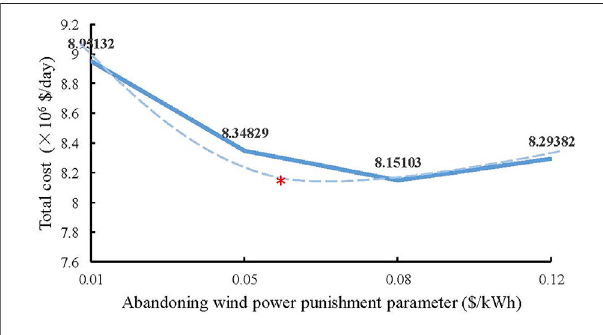
FIGURE 10 | Curve line chart of the in fl uence of δ WP on C total